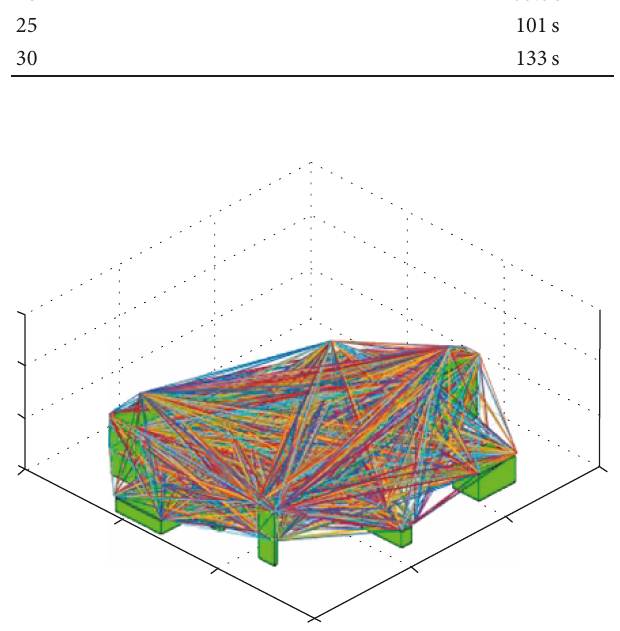
Figure 9: A sample of roadmap visualization in the simulation with 10 obstacles.